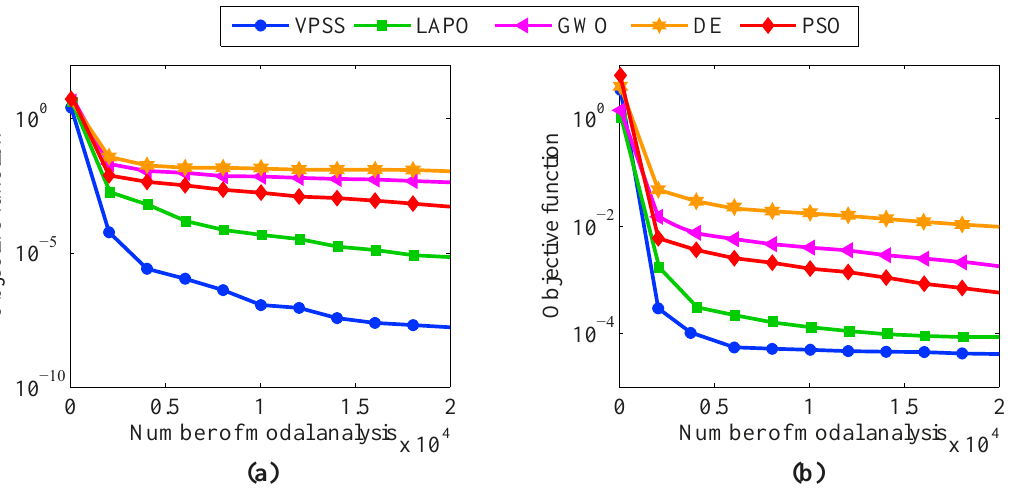
Figure 16. Convergence histories of mean objective function values of VPSS, LAPO, GWO, DE, and PSO for the Canton Tower in the ( a ) noise-free condition and ( b ) noisy condition.